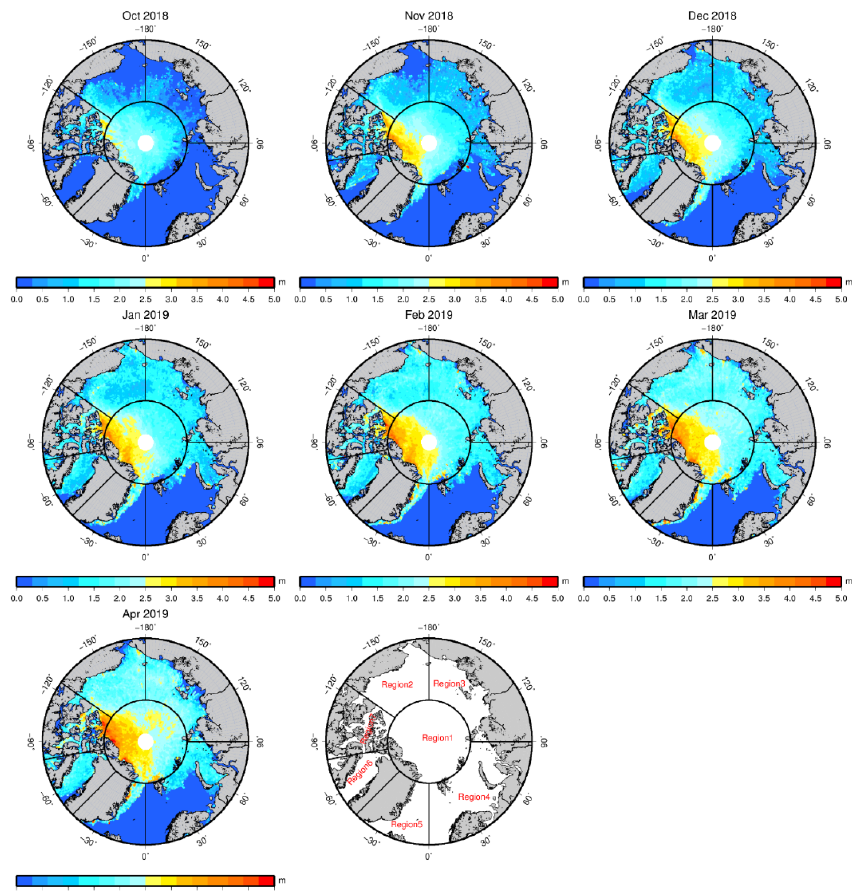
Figure 2. Arctic sea ice thickness distribution with the least squares adjustment (LSA) method for the 2018–2019 Arctic sea ice growth season from October to April. The thickness distribution is presented in seven regions, region 1: Arctic Ocean; region 2: Beaufort and Chukchi Seas; region 3: Laptev and East Siberian Seas; region 4: Kara and Barents Seas; region 5: Greenland Sea; region 6: Ba ffi n Bay; and region 7: Canadian Arctic